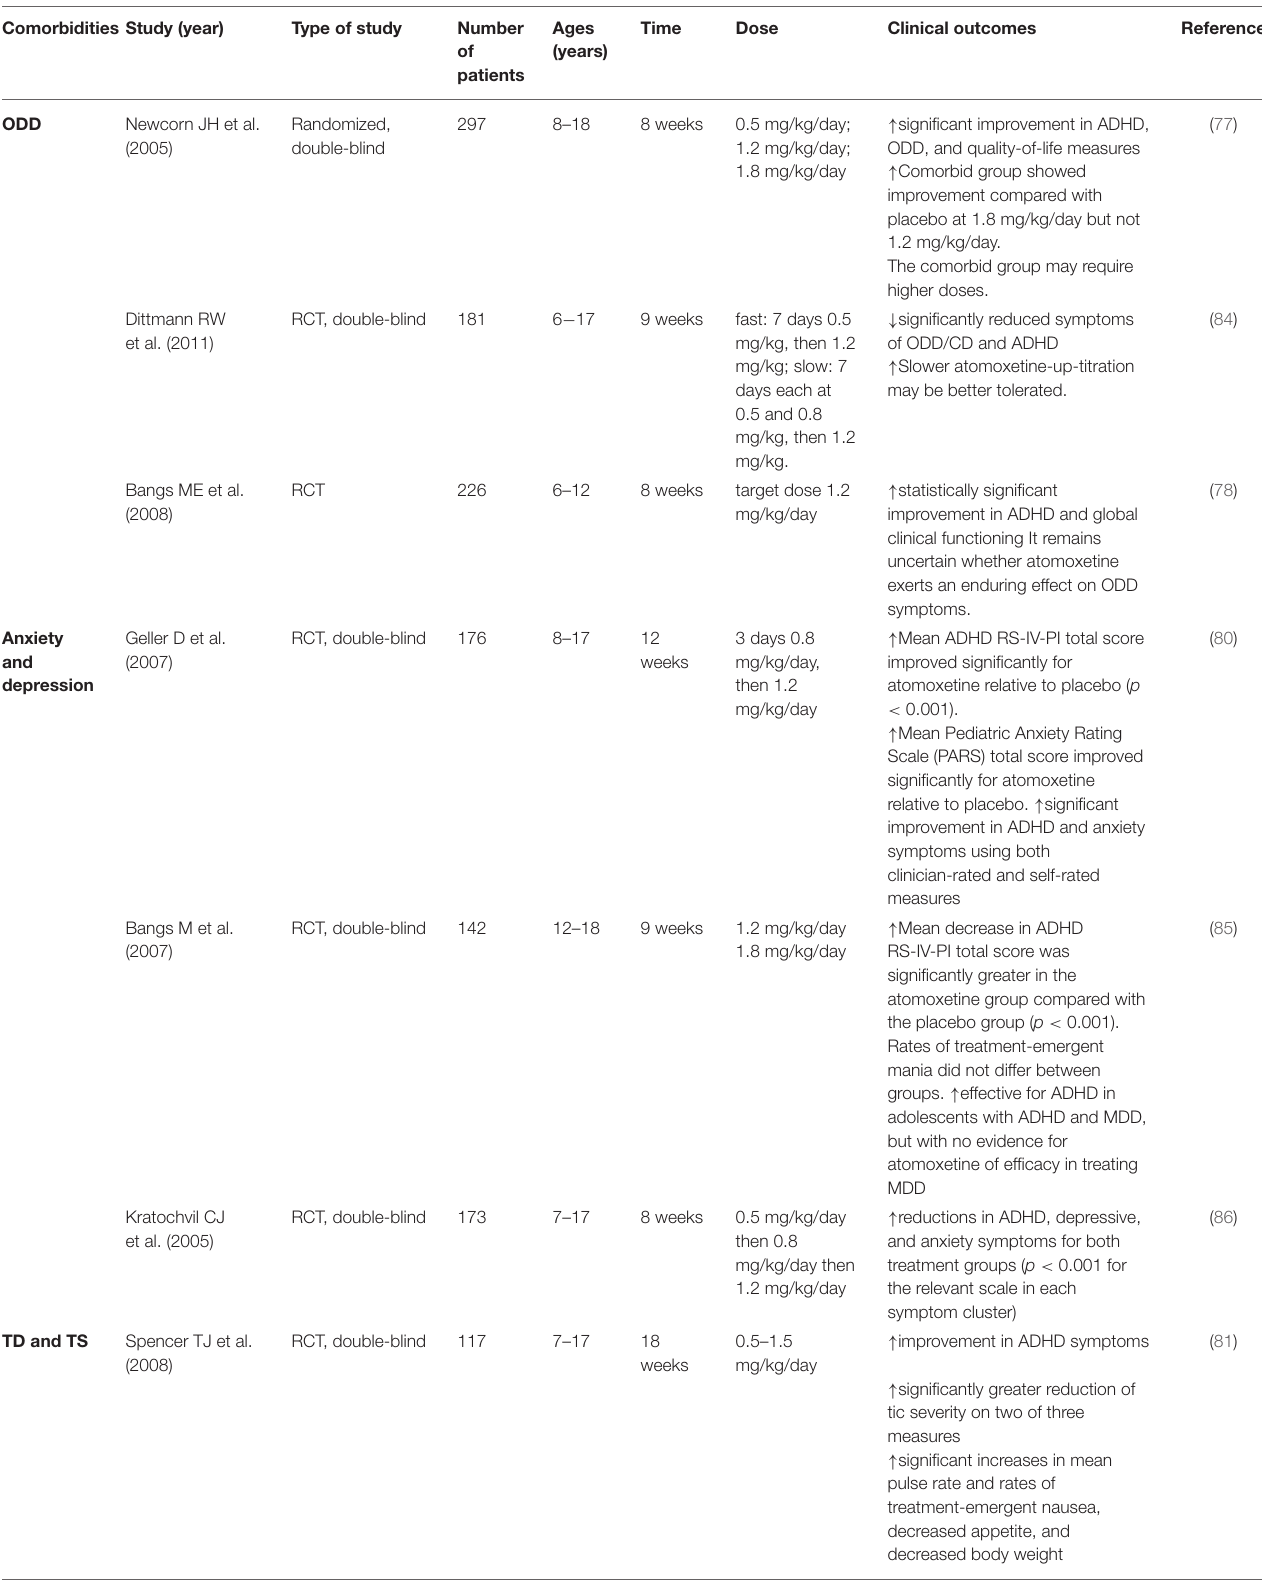
TABLE 2 | Efficacy of atomoxetine treatment in comorbidities of ADHD. Comorbidities Study